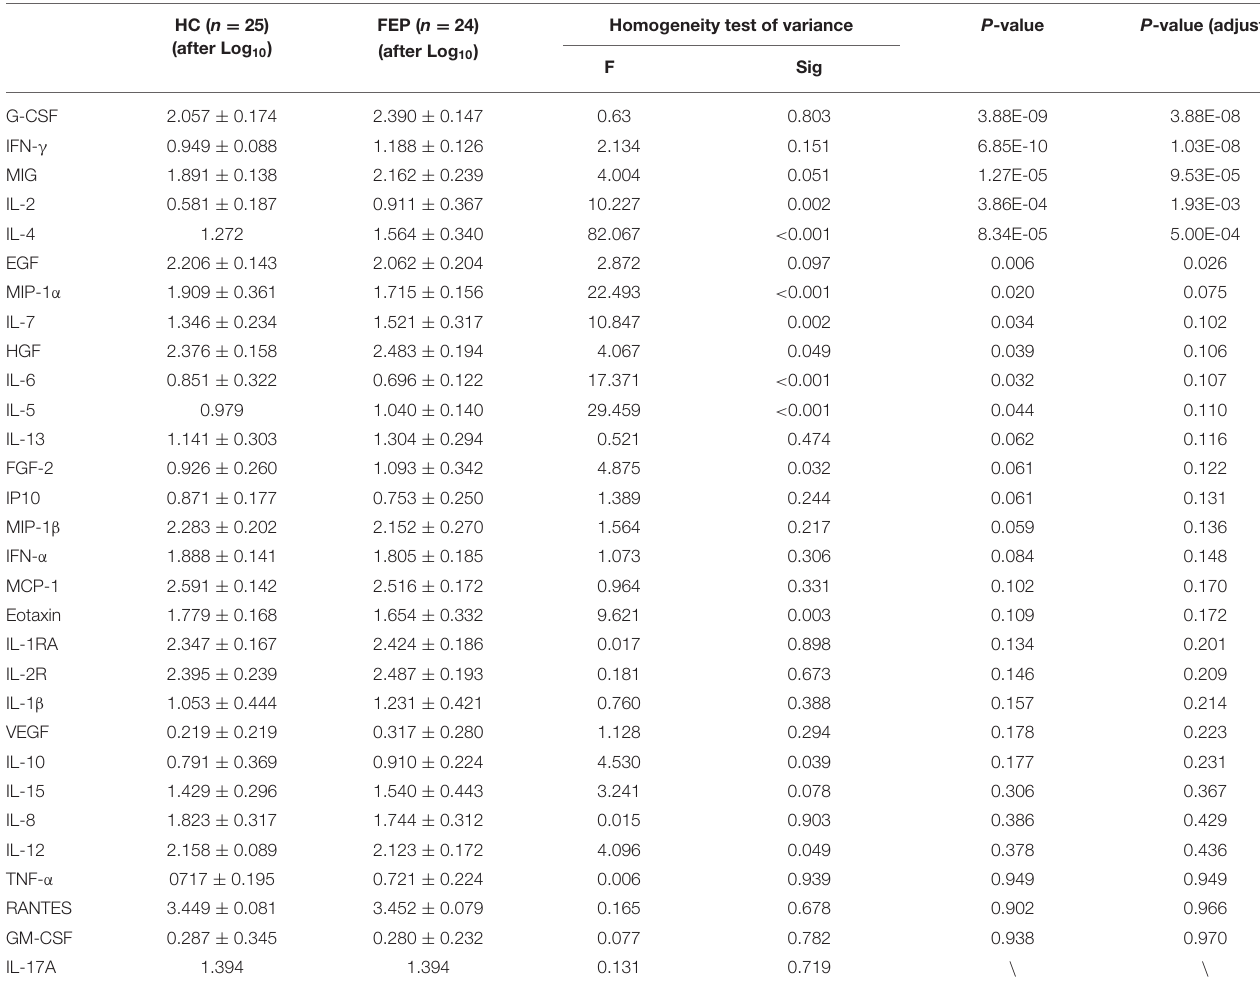
TABLE 1 | Dysregulated serum cytokine levels in FEDF patients. HC ( n = 25) FEP ( n = 24) Homogeneity test of variance P -value P -value (adjust) (after Log 10 ) (after Log 10 )